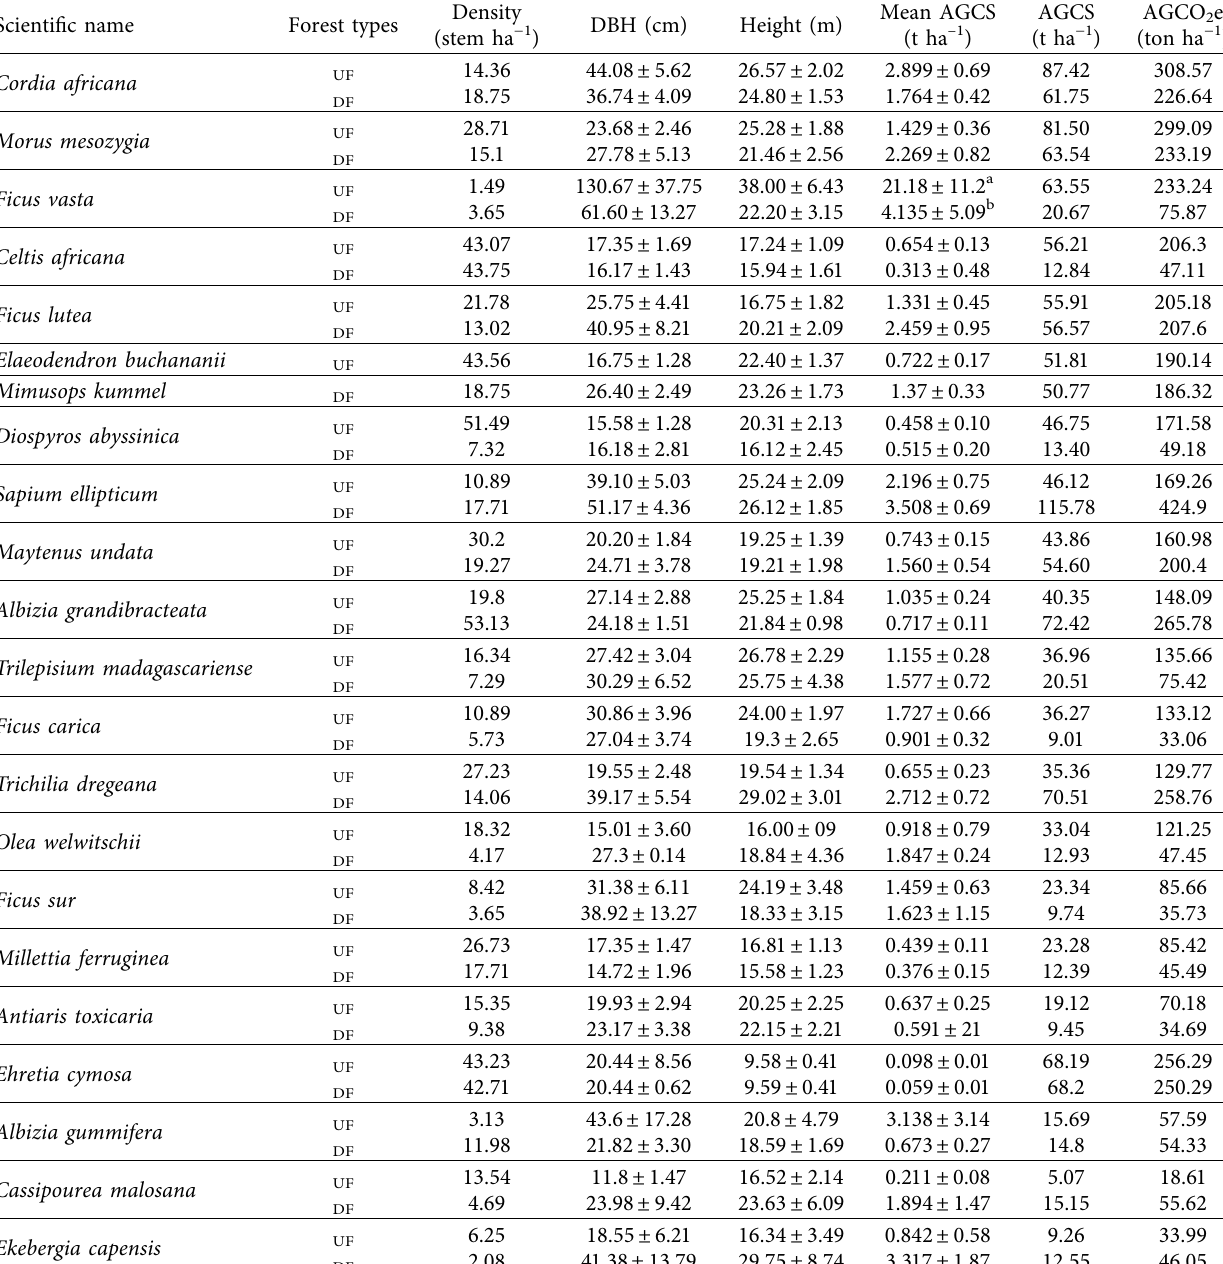
Table 4: Comparison of aboveground carbon stock between large diameter tree species in UF and